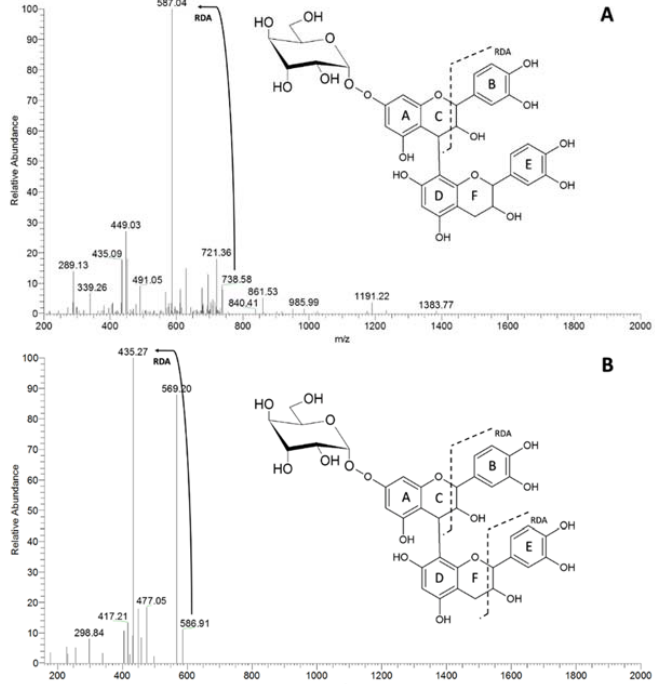
Figure 4. MS/MS spectra of the ion at m / z 739, evidencing the main patterns of fragmentation of hexosyl PAs. RDA = retro Dies-Alder. ( A ) MS² spectrum of the precursor ion of m / z 739 [M-152-H] − ; ( B ) MS³ spectrum of the precursor ion of m / z 739 [M-152-152-H] − .